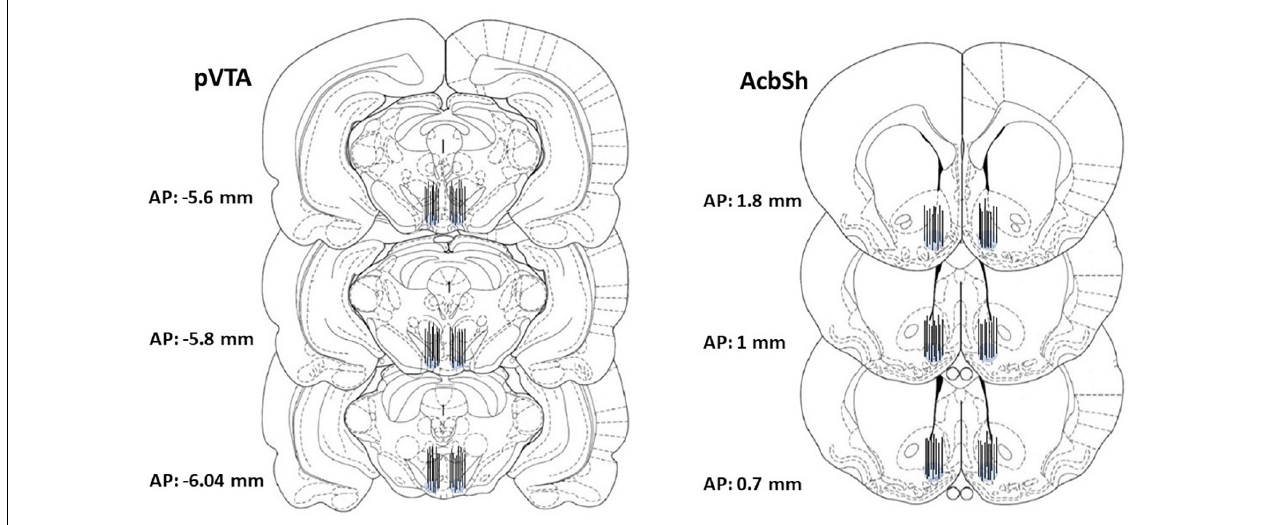
FIGURE 2 | Representative images of the localization, within the pVTA and the AcbSh, of the dialyzing portion of dialysis probes drawn, after histological examination, in the brain atlas plates showing the pVTA and the AcbSh at different AP distances from bregma according to the rat brain atlas of Paxinos and Watson (1998).